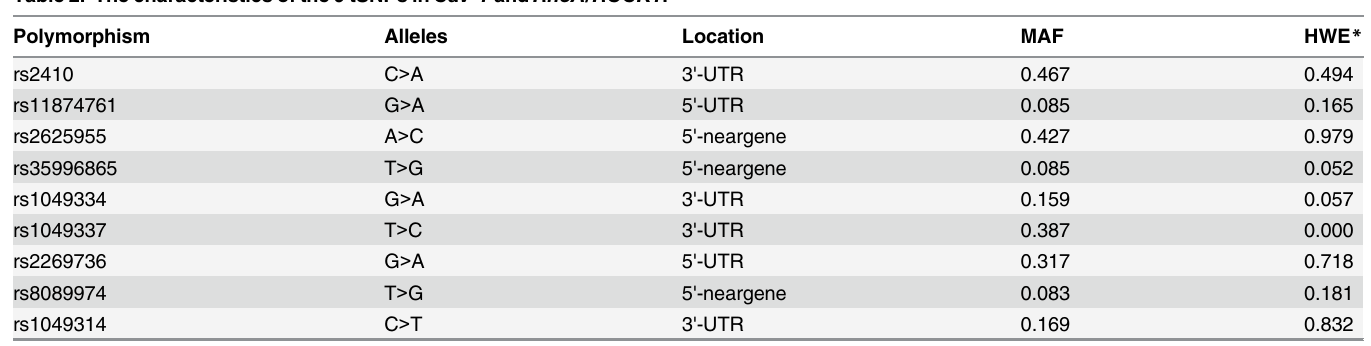
Table 2. The characteristics of the 9 tSNPs in Cav-1 and RhoA/ROCK1 .